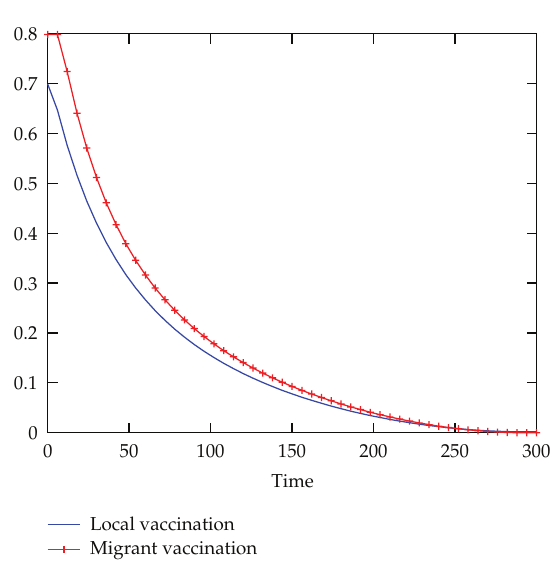
Figure 4: The vaccination strategies for the two groups, Example 4.2.